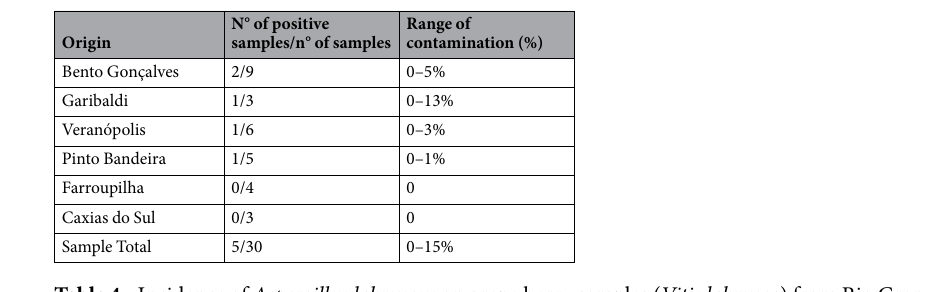
Table 4. Incidence of Aspergillus labruscus on grape berry samples ( Vitis labrusca ) from Rio Grande do Sul, Brazil.